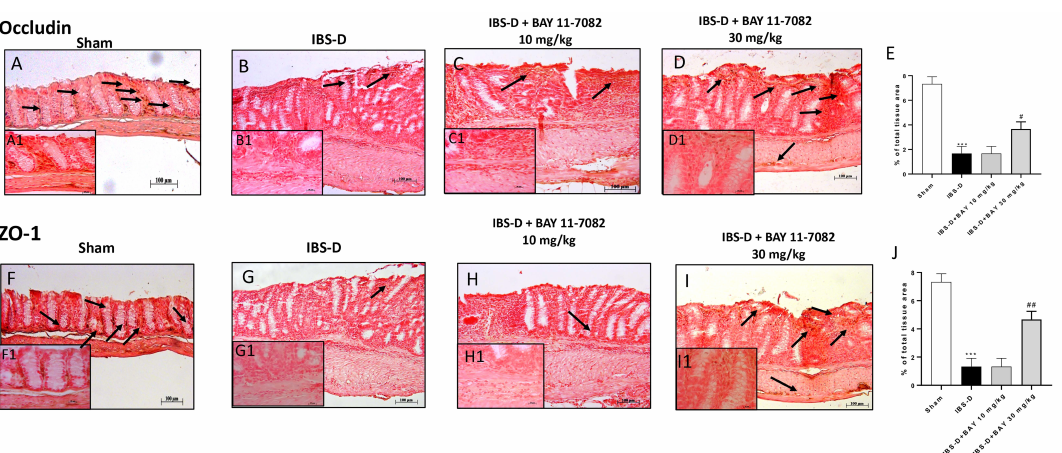
Figure 2. E ff ect of BAY 11-7082 treatment on TJ expression. Basal expressions of occludin and ZO-1 have been found in the colon tissue of the sham group (( A , F ) respectively) compared to the IBS-D group where a reduction of their expression was evident (( B , G ) respectively). The treatment with BAY 30 mg / kg restored the expression of occludin and ZO-1 to almost basal levels as shown in ( D , I ) compared to BAY 11-7082 10 mg / kg ( C , H )). Black arrows display the positive staining. Data are representative of at least three independent experiments. ( E ) *** p < 0.001 vs. Sham. # p < 0.05 vs. IBS-D. ( J ) *** p < 0.001 vs. Sham. ## p < 0.01 vs.